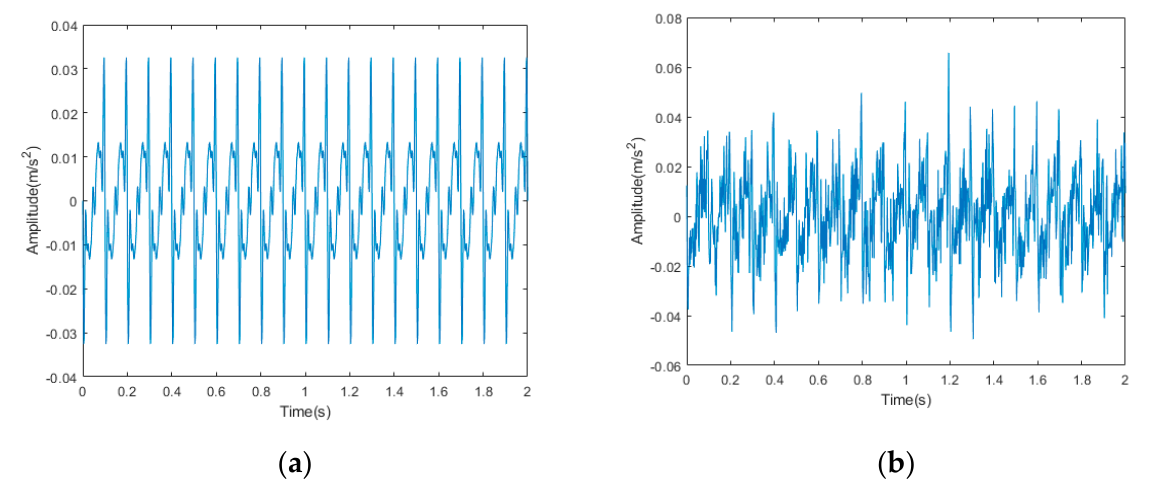
Figure 2. Time domain signal diagram: ( a ) original signal; ( b ) noisy signal.